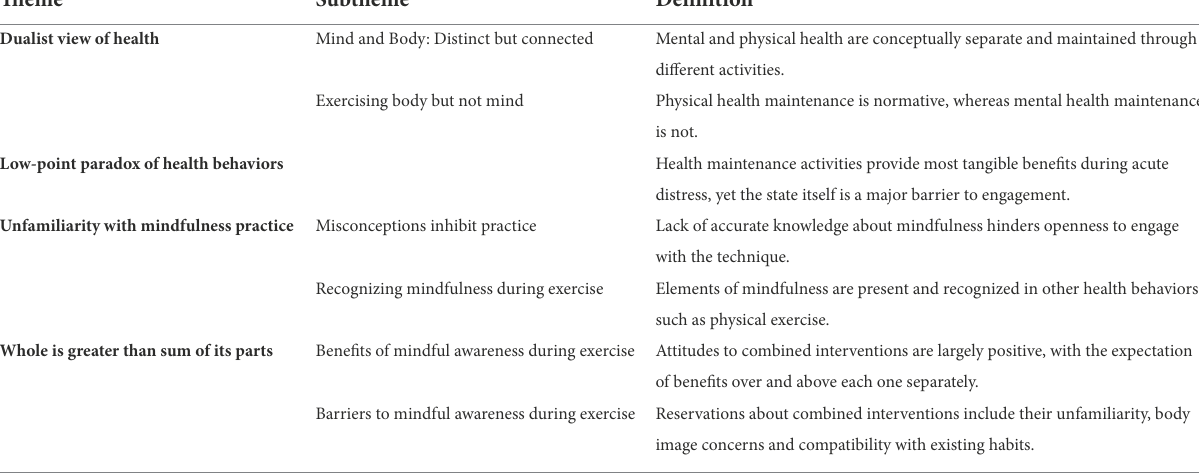
TABLE 2 Themes and subthemes created through reflexive thematic analysis of interview